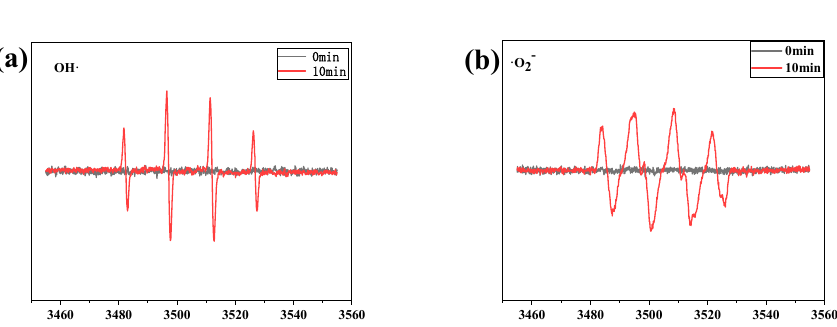
Figure 10. ESR signals of ˙OH (a) and ˙O 2 − (b) measured using BOB/ZFO–10 as the sample. In the self-assembly process of BiOBr, the ferroelectric ZnFe 2 O 4 plays roles not only as a crystal attachment point, but also in the intrinsic ferroelectromagnetism affecting the surface morphology [47], crystal facet growth and the direction of the internal polarization field of BiOBr during the material assembly, as in Monzon‘s work [48]. In other words, when BiOBr is synthesized by this process, during the self-assembly process, instead of tending to be a nanosheet structure, the crystal formation of BiOBr is induced by a weak magnetic field around ZnFe 2 O 4 and a spherical structure with less surface energy is formed around the ZnFe 2 O 4 crystalline nucleus. Simultaneously, the anions and cations are migrated according to the distribution of the magnetic field, forming a uniformly oriented polarization field with orientation (010). As shown in Figure 11a, the uniformly oriented polarization field provides a photogenerated electron highway (PGEH) for the transfer of electrons. The electrons passing through the PGEH exhibit a higher transfer efficiency and a lower recombination probability. This result agrees well with the significant increase in the photocurrent as well as a short Nyquist radius (Figure 8).